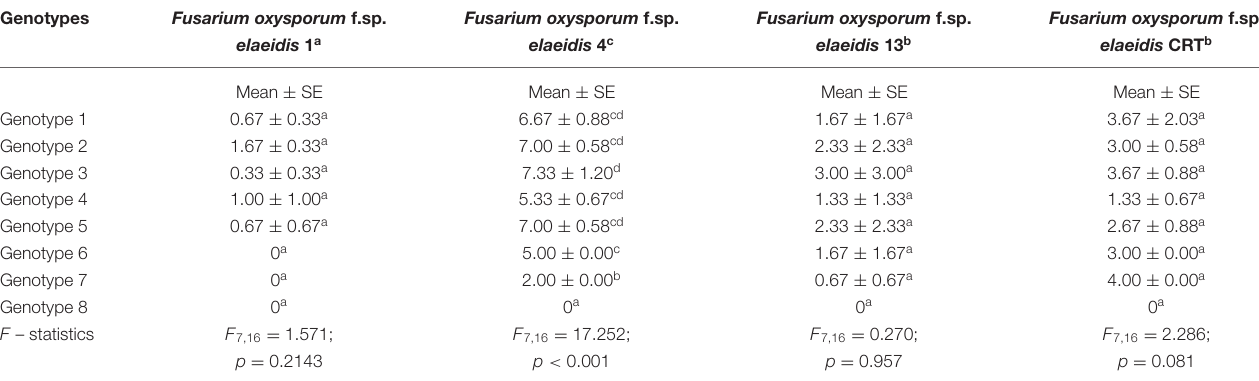
TABLE 5 | Mean ± SE of Score Incidence of Fusarium oxysporum f.sp. elaeidis on oil palm genotypes in the leaf and root symptom category.